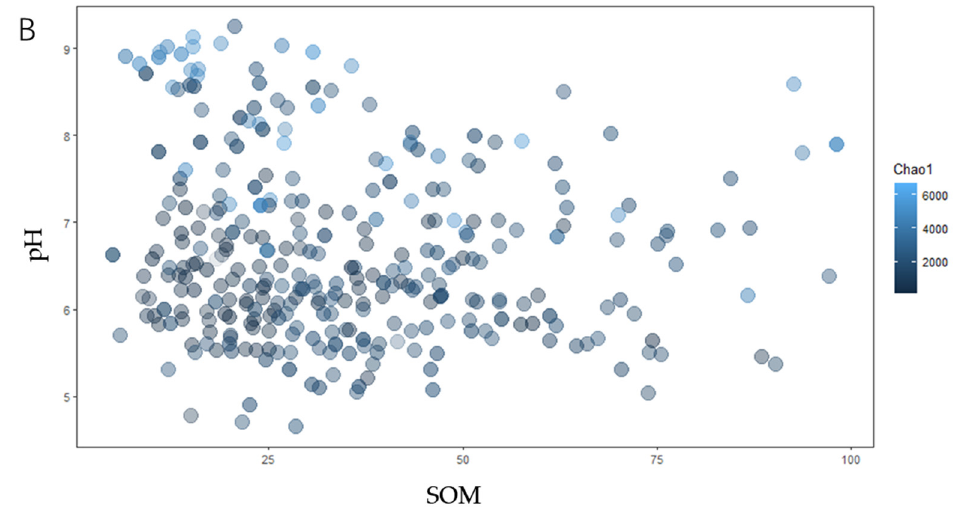
Figure 8. Comparison of the distribution of soil bacterial abundance under the conditions of altitude and accumulated temperature ( A ), and pH and soil organic matter ( B ). The darker the color of bubbles, the higher the Chao1 index. ( A ) Altitude (m), AT (°C); ( B ) SOM (g/kg).